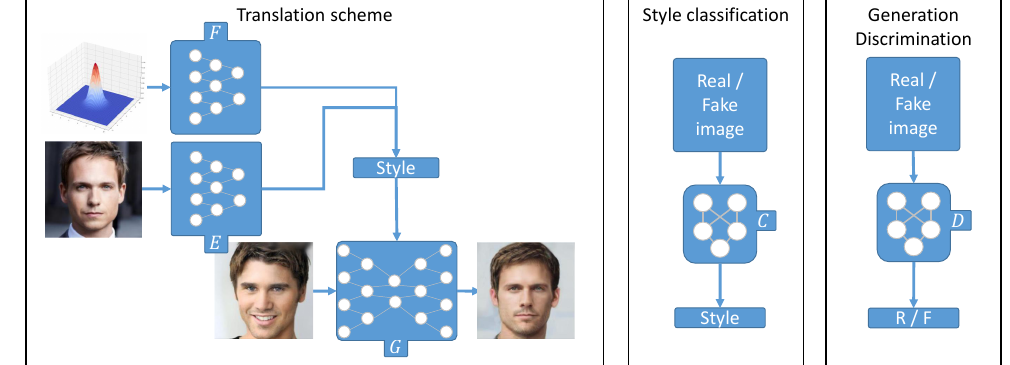
Figure 5. General attribute editing process in I2I translation methods. E is the style encoder, F is the mapping network that permits the model to explore more modes, G is the generator, D is the discriminator and C is the attribute classifier introduced in [10]. Face images were taken from StarGAN v2